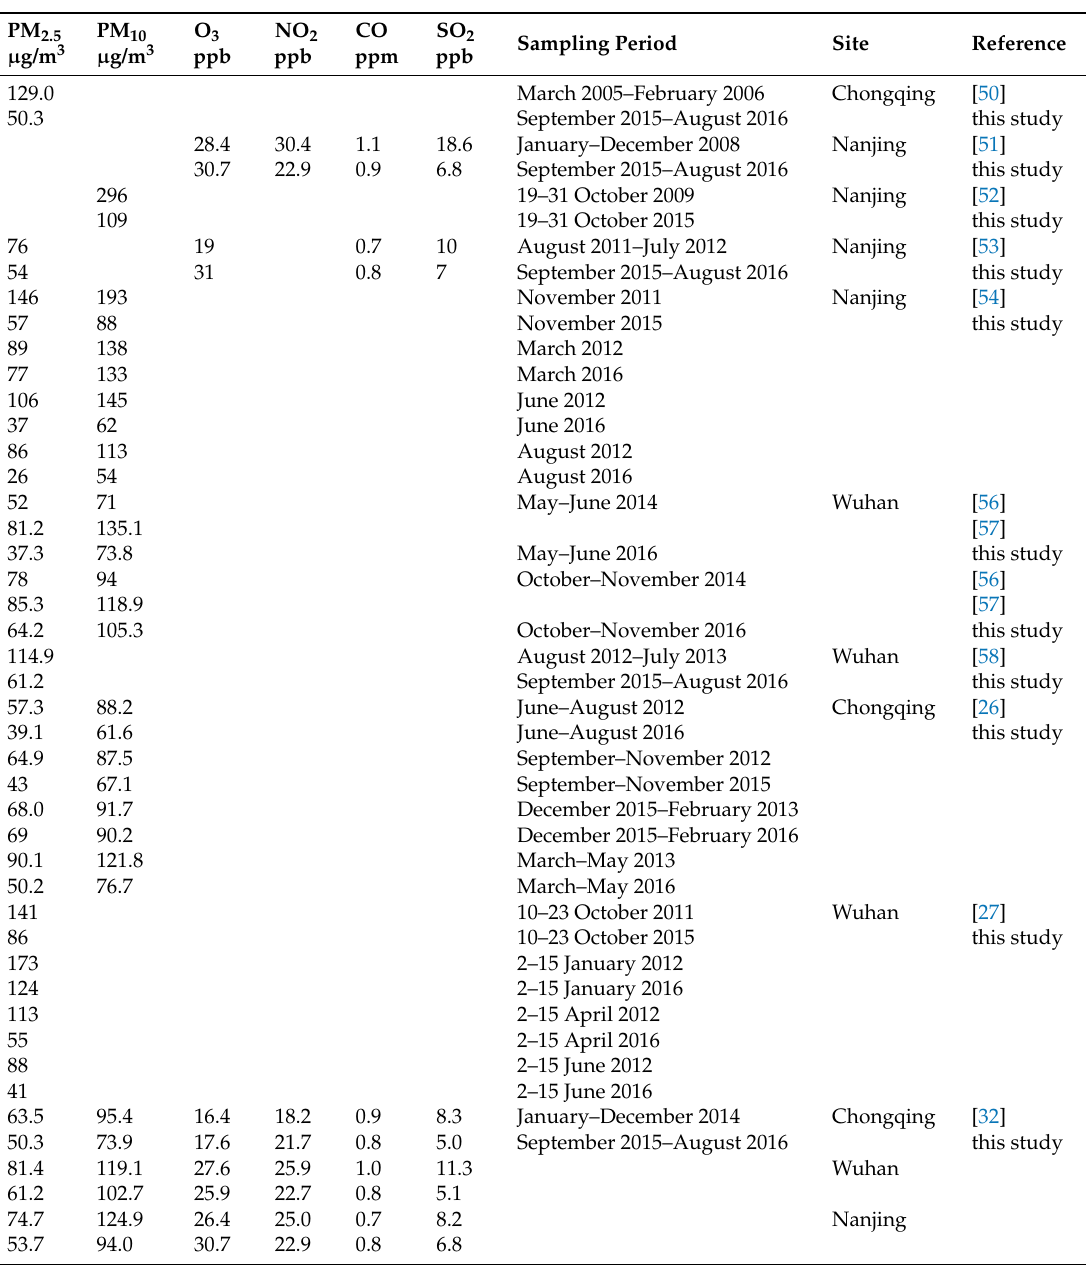
Table 4. Comparisons of air pollutants in three cities with other studies. Note here 1 h average concentrations of O 3 were